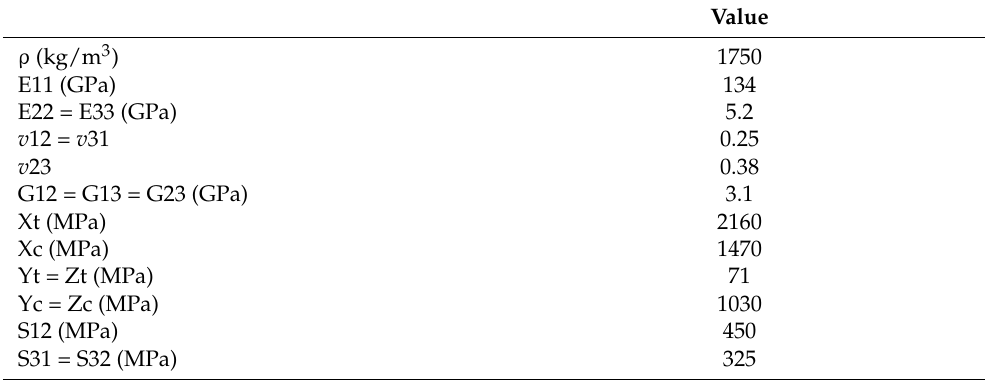
Table 4. T700s mechanical properties of unidirectional carbon fiber plate